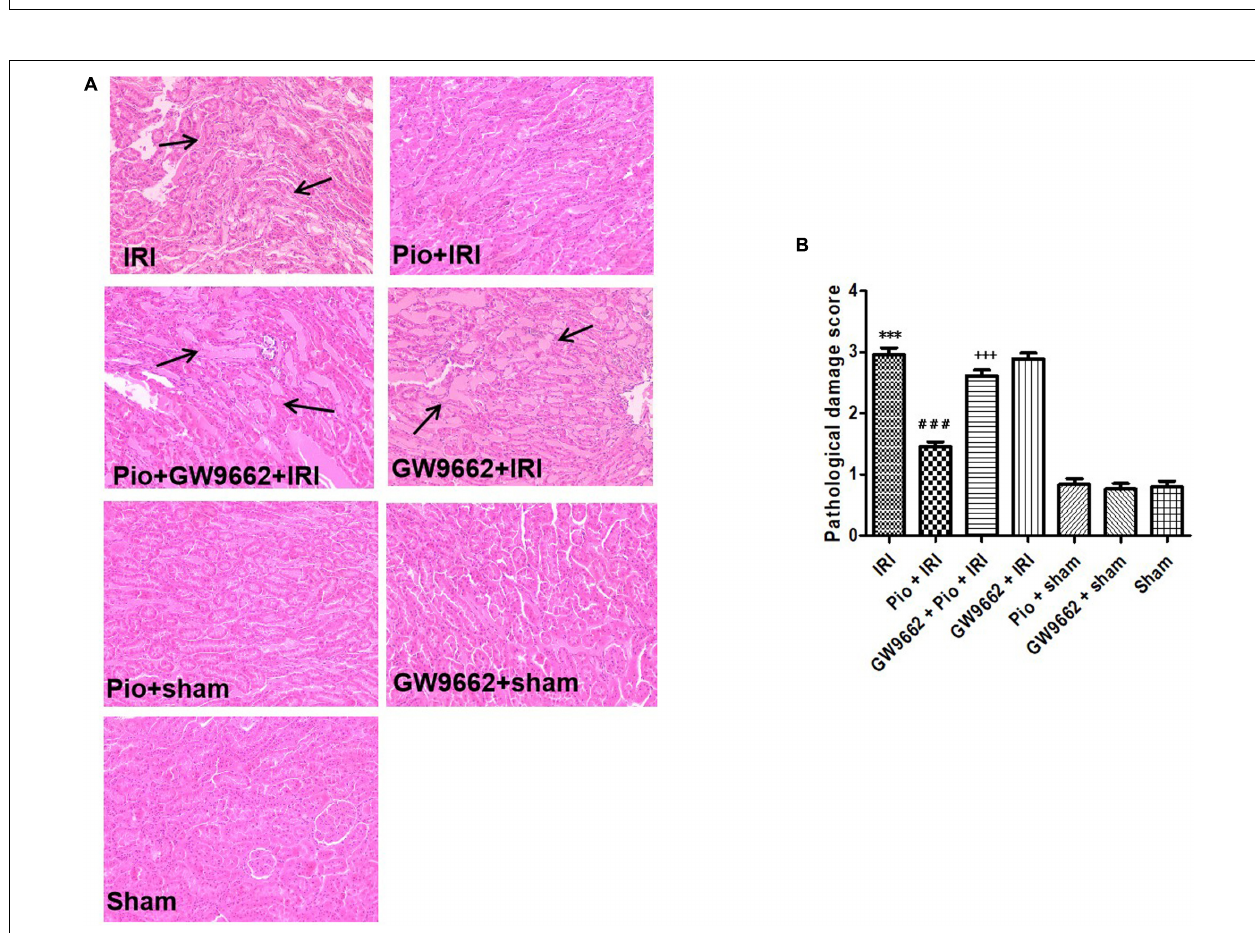
FIGURE 3 | Histological evaluation of the renal tissue at 24 h after renal IRI. (A) Representative photographs of kidney sections stained with hematoxylin and eosin (original magnification 200 × ). (B) Histological scoring of the kidney sections. Arrows indicate tubular dilatation, swelling, congestion, vacuolization, and tubular necrosis in the kidneys ( n = 4). Compared to the sham group, ∗∗∗ represents p < 0.001; compared to the IRI group, ### represents p < 0.001; compared to the Pio + IRI group, +++ represents p < 0.001.